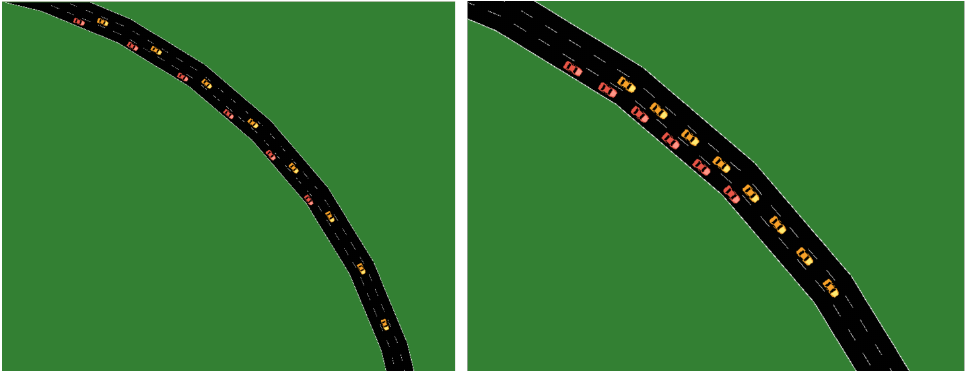
Figure 11. Collision avoidance by lane change.